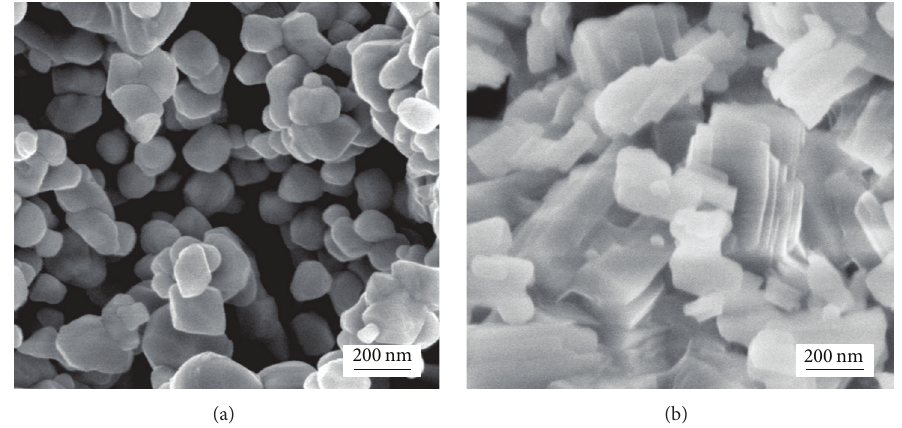
Figure 5: SEM images of the precursor: (a) mechanical solid-state reaction; (b) hand-grinding.